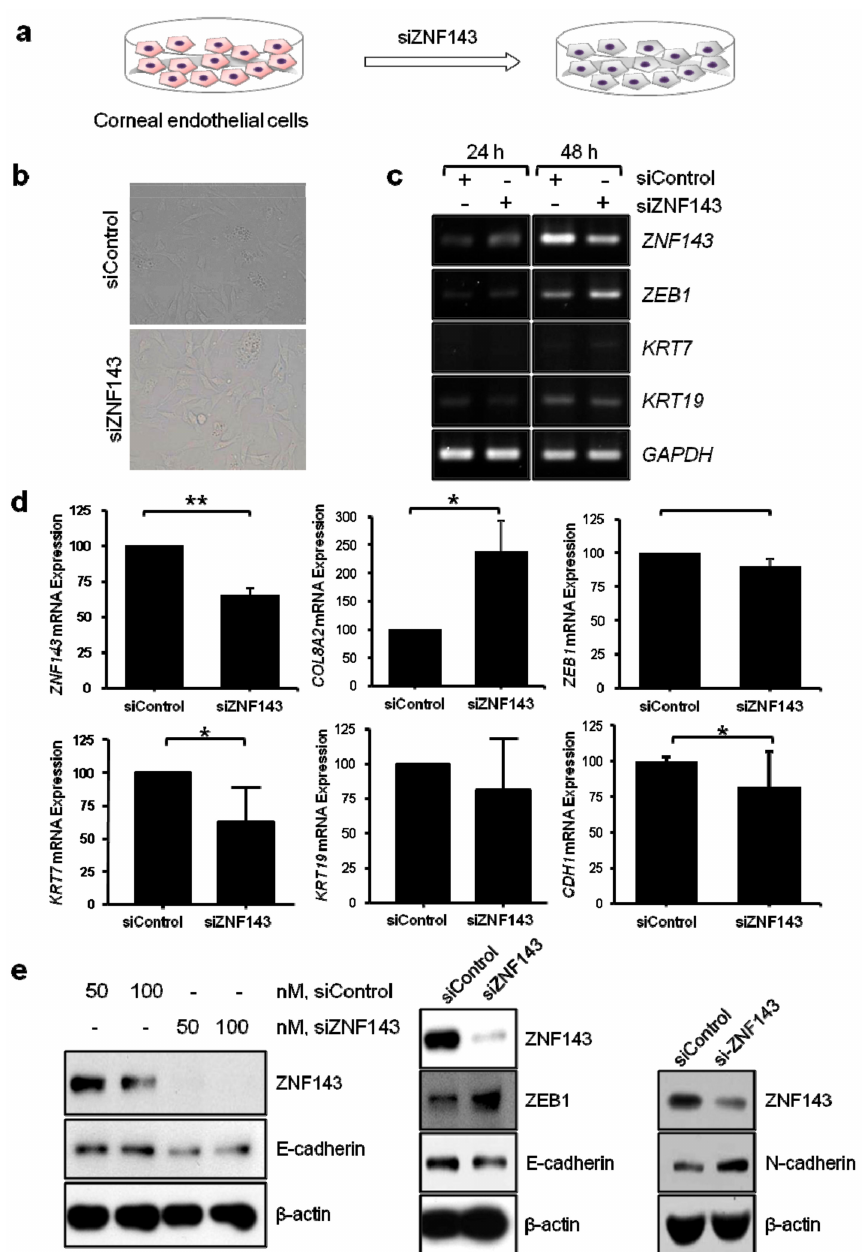
Figure 3. The e ff ect of ZNF143 expression in human corneal endothelial cells (hCECs). ( a ) hCECs were transfected with small interfering (si)RNA against ZNF143 (siZNF143) or control siRNA and grown for 24 h or 48 h. ( b ) Before harvest, pictures of the cells were taken at 20 × magnification by using an inverted light microscope (Olympus, Japan). Cells were harvested for RT-PCR ( c ), RT-qPCR ( d ), and immunoblotting ( e ). siZNF143 transfected hCECs revealed a decreased expression of KRT7 , CDH1 , and E-cadherin, and an increased expression of COL8A2 , N-cadherin, and ZEB1 . The results shown are representative of at least three independent